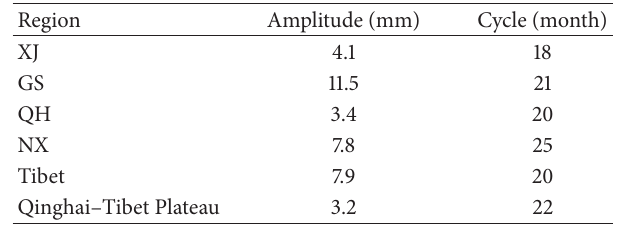
Table 2: Cycle of WSC over northwestern